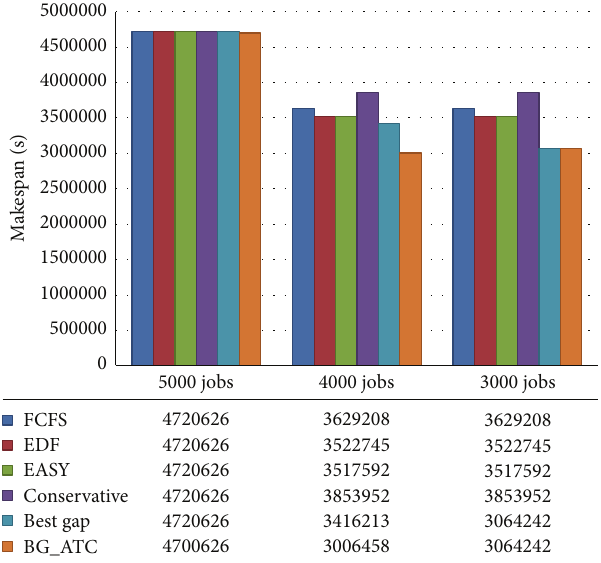
been depicted in Figure 6. The lower value of makespan is the substantiation for higher machine utilization. The makespan of FCFS, EDF, and EASY backfilling algorithms was almost the same. The BG ATC climbs lower makespan in the chart which is the evidence for the better machine. Since the makespan is the completion time of the last job, makespans of few algorithms are near to one